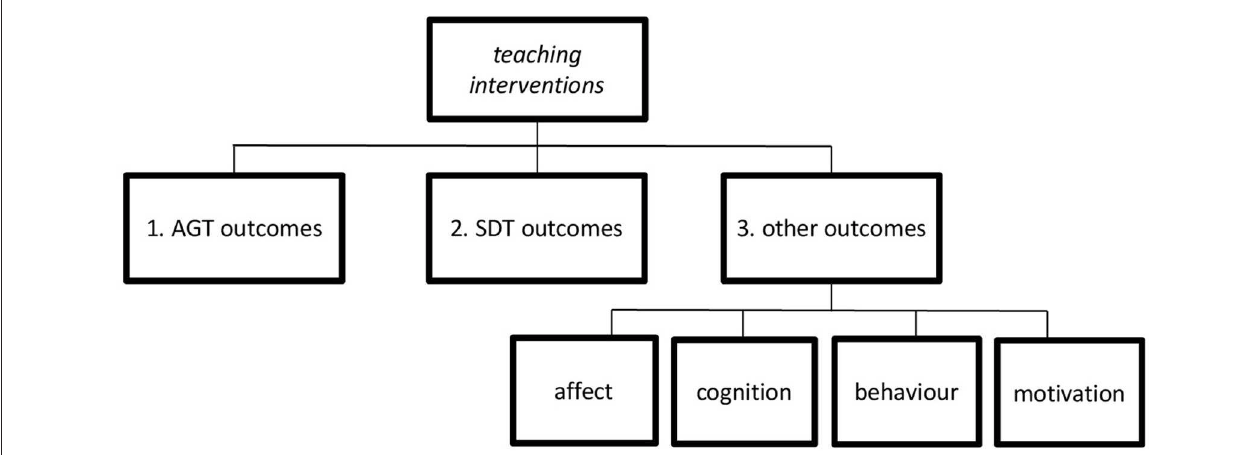
FIGURE 4 | Structuring categories for included intervention studies. This figure depicts the different categories that were used in organizing the teaching intervention studies based on outcomes.